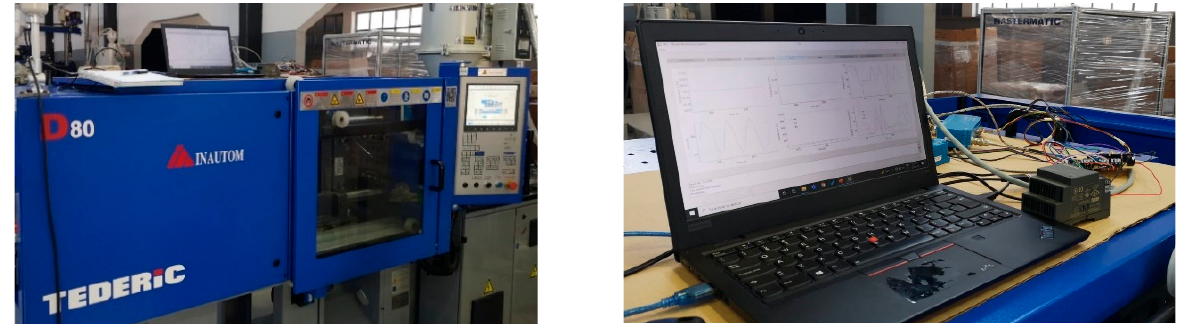
Figure 9. Test setup with the working monitoring system and injection molding machine.